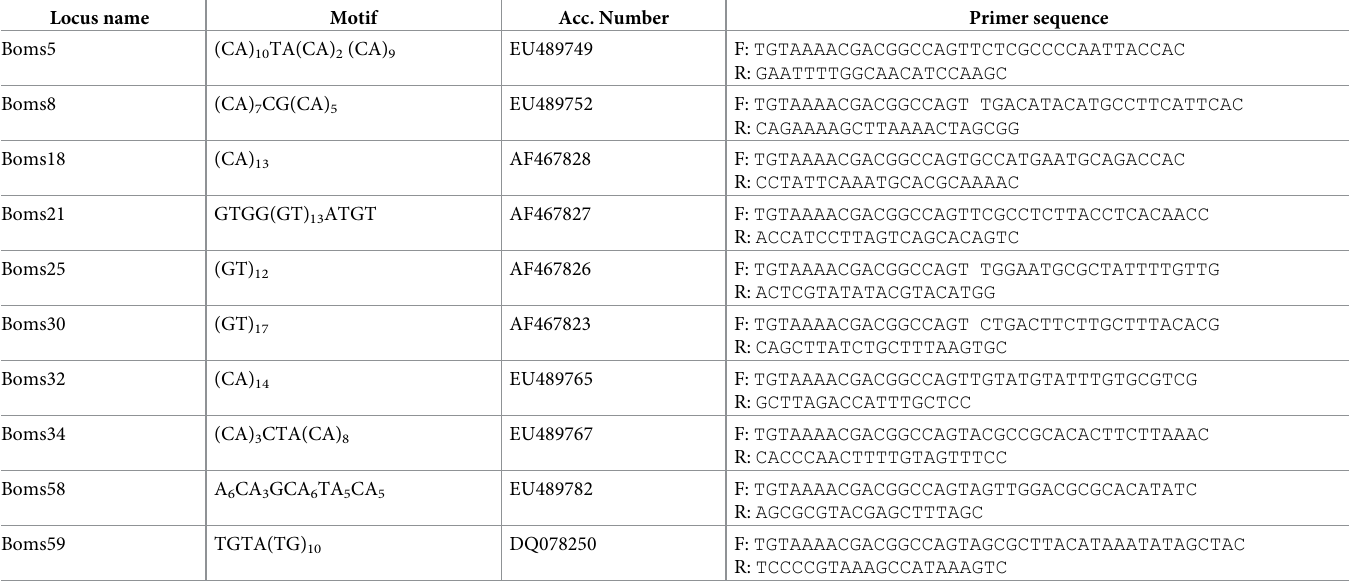
Table 2. Microsatellite [28] loci motif, accession numbers and primer